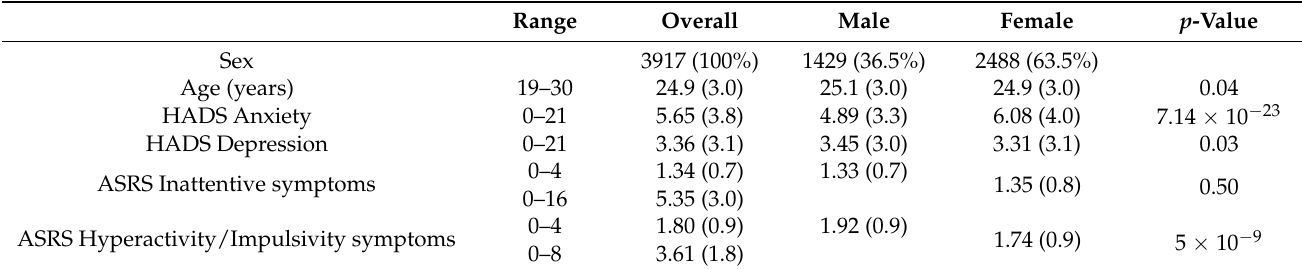
Table 1. Input variables for model selection, p -values for two sample t -tests for between-sex differences and chi-square for proportions of sex. HADS: Hospital Anxiety and Depression Scale, ASRS: Adult ADHD Self Report Scale—Screener.